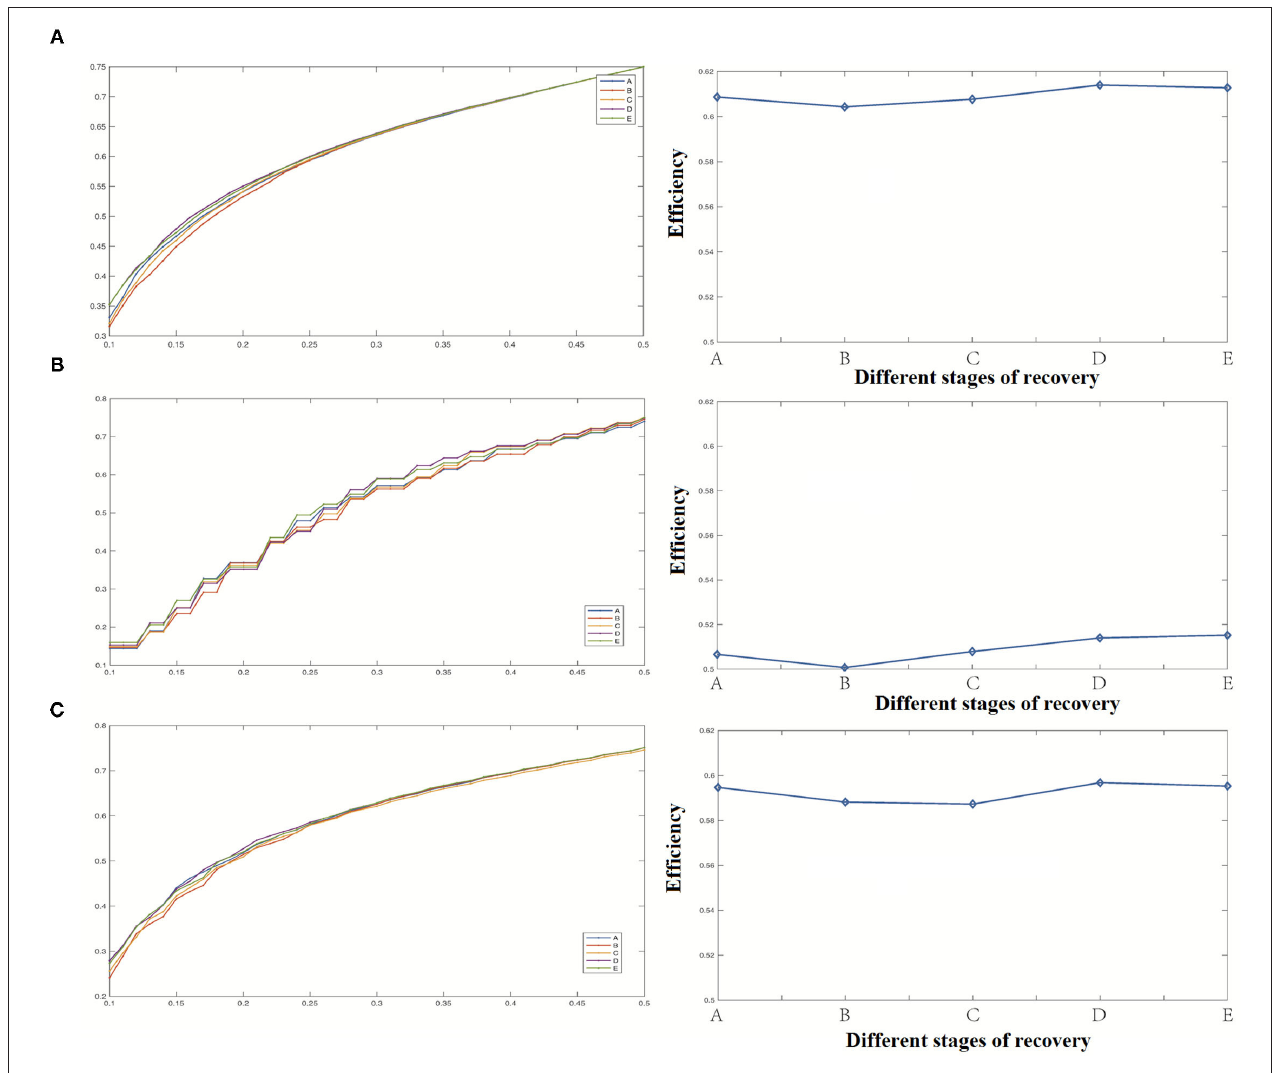
FIGURE 8 | Efficiency analysis results [ (A) Efficiency of the whole network, (B) Efficiency coefficient of the cortical region, (C) Efficiency of the deep